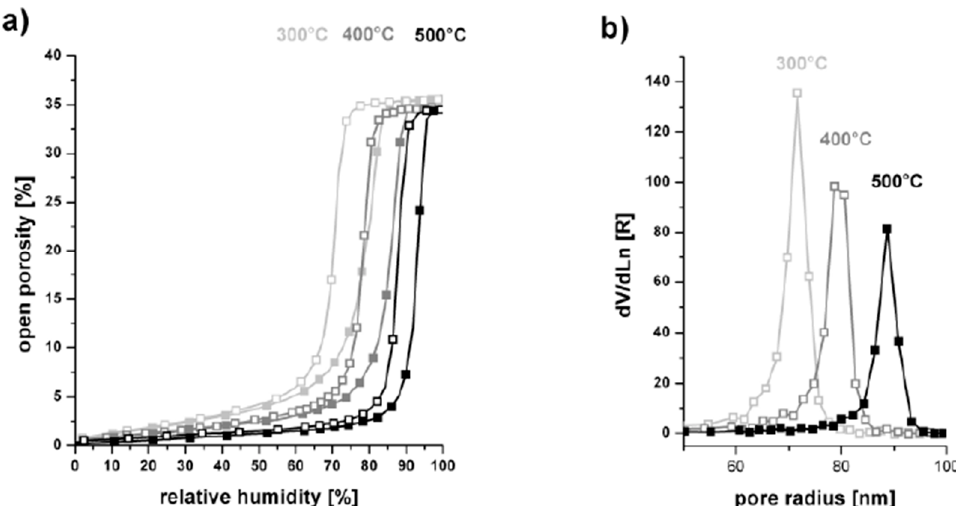
Figure 3. Adsorption (filled symbols) and desorption (open symbols) isotherms of MgF 2 thin films treated at 300, 400, and 500 °C, measured by ellipsometric porosimetry ( a ). Derivative pore radius distributions as calculated from the respective desorption branch ( b ). Reproduced from Reference [36] with the permission of the Royal Chemical Society.